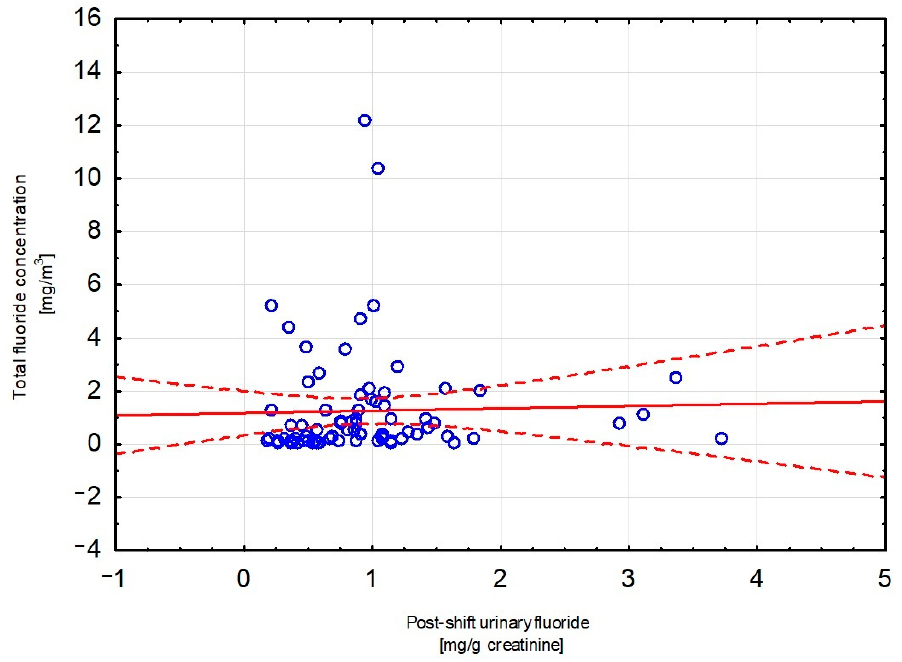
Figure 3. Correlation graph between total (particulate + gas-phase) fluoride concentrations in the occupational environment and post-shift urinary levels.